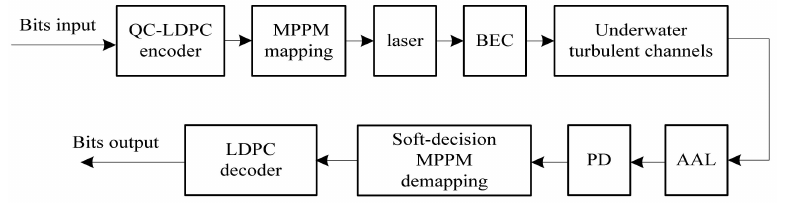
Figure 1. Schematic of the LDPC-coded MPPM UWOC system over turbulent